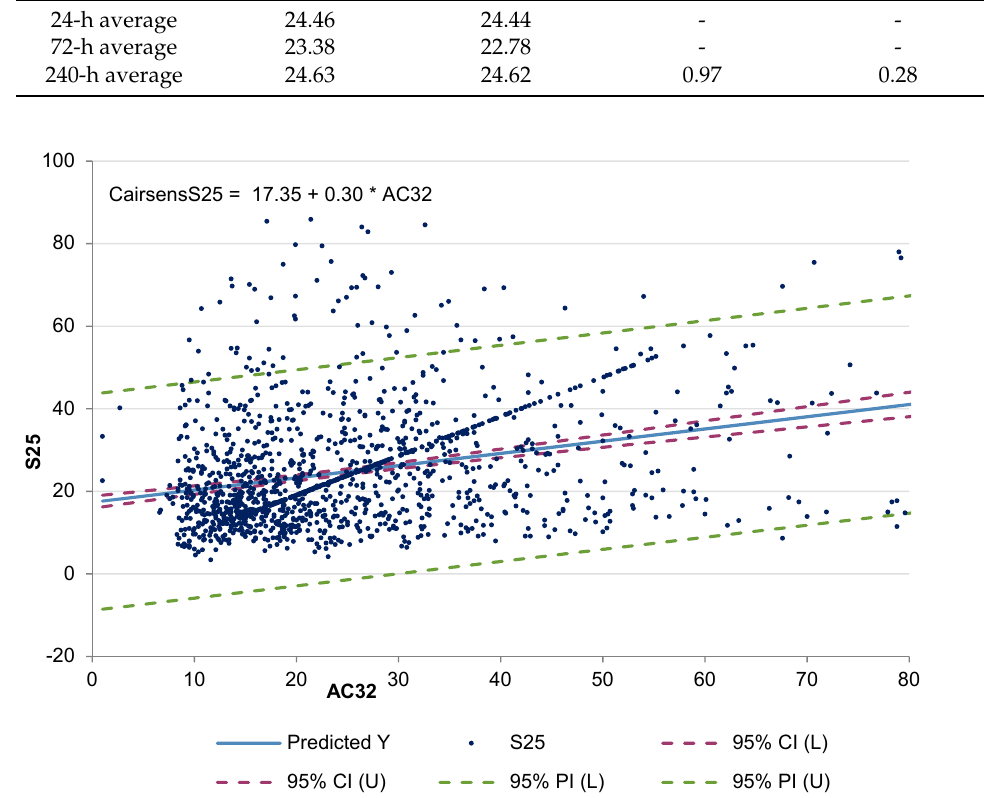
Figure 7. Regression plot of reference (AC32) vs. sensor (S25) datasets.